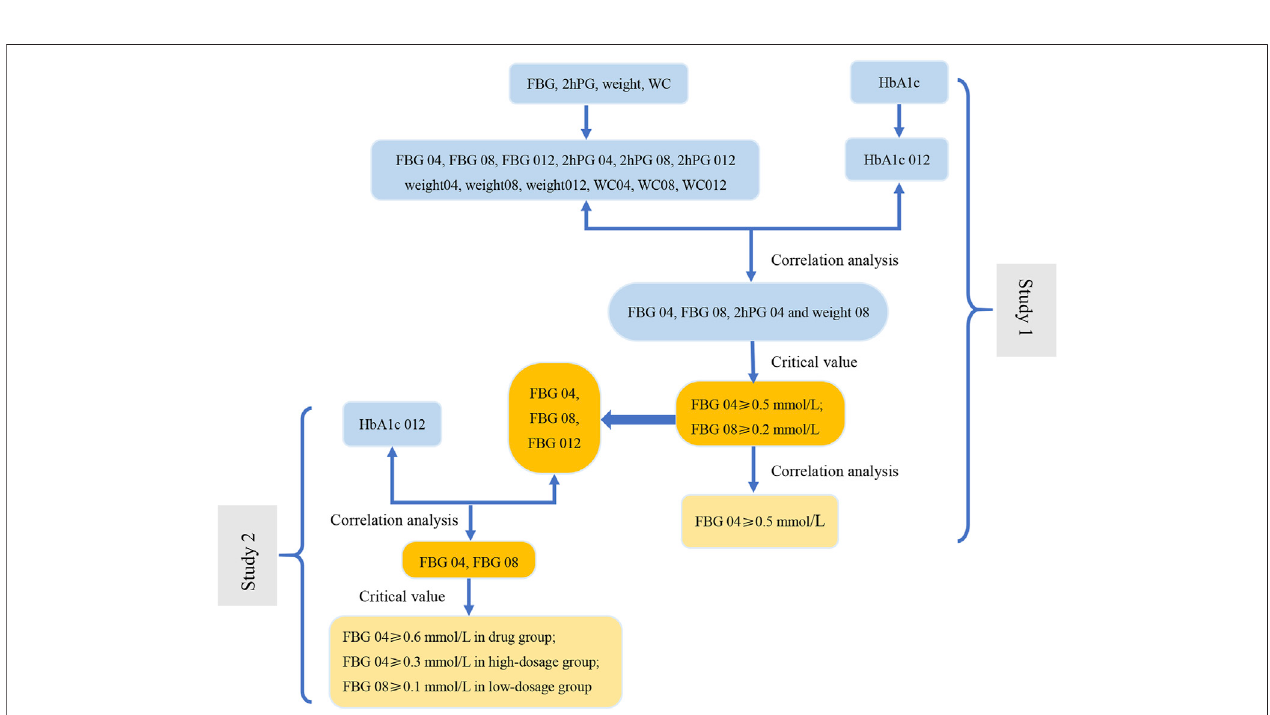
FIGURE 5 | The fl ow diagram of results of this study. In Study 1, the correlation analysis between the change range of indicators at three time points (weeks 4, 8, and12)frombaselineandthedecreaseinHbA1catweek12frombaseline(HbA1c012)wascarriedouttoscreentherelatedindications(FBG04,FBG08,2hPG04and weight 08). Next, we evaluate the related indications and the respective critical values to determine the key indicator (FBG), indications (FBG 04 and FBG 08), and the most appropriate critical values (0.2 mmol/L and 0.5 mmol/L). The results of correlation analysis between FBG 04 and FBG 08 indicate that FBG 04 was the key indicationand0.5 mmol/Lwasthemostappropriatecriticalvalue.Weconductedacorrelationbetweenthechangerangeofkeyindicator(FBG)atthreetimepointsfrom baseline (FBG 04, FBG 08, and FBG 012) and HbA1c 012 to screen the key indications in the drug group, high-dose group, and low-dose group in Study 2. Key indications with critical values were determined to investigate the most appropriate critical value in the three groups separately.